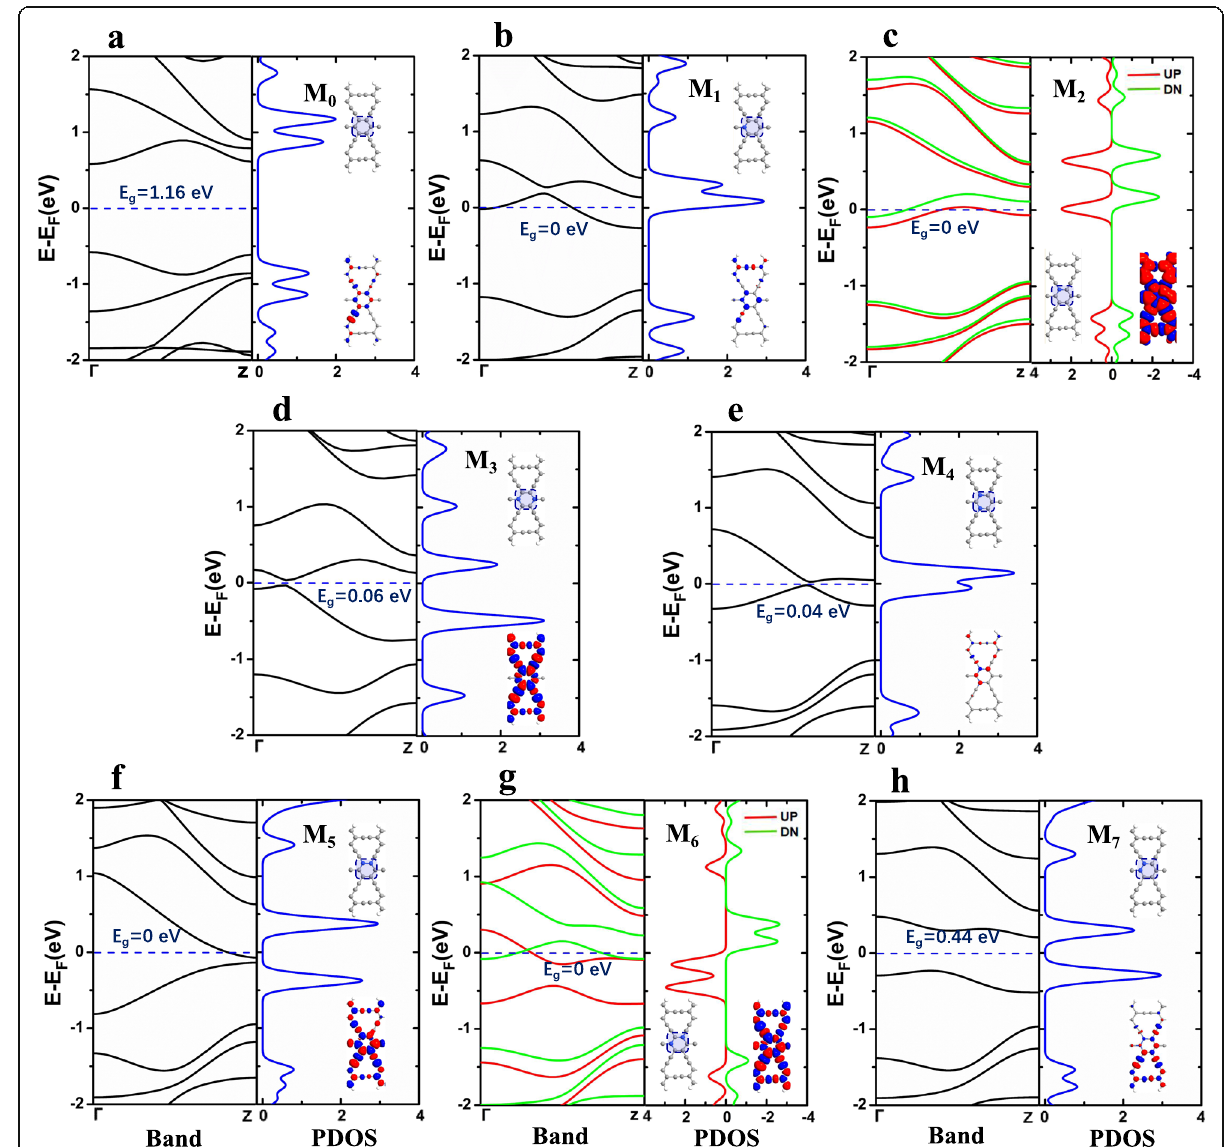
Fig. 2 (Color online) The electronic band structure (in the left panels) and spin density distribution (the insets in the right panels of each pictures with red and blue clouds which indicate positive and negative electrons) for the super unit cells of M 0 – M 7 corresponding to the a – h . The horizontal blue dashed line is also drawn to indicate the position of the Fermi energy level. The projected density of state (PDOS) in the right panels of a – h is the density of state with respect to all the atoms of the hexagonal rings inside the blue shaded frame, respectively. Here, the red and green lines represent the spin-up (UP) and spin-down (DN) components for M 2 and M 6 in c and